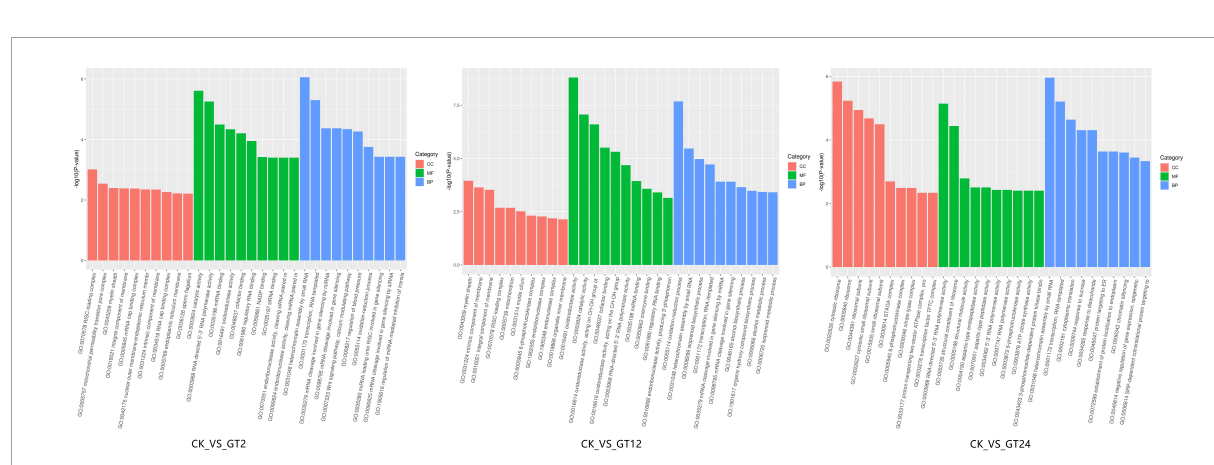
FIGURE2 Gene Ontology (GO) functional enrichment analyzes of differentially expressed genes (DEGs).